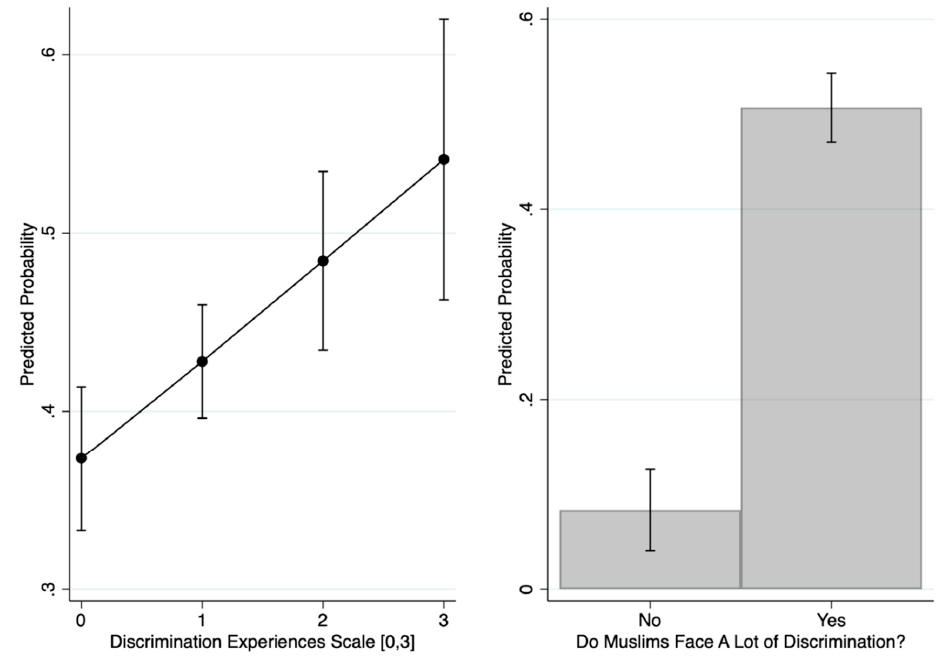
Figure 7. Predicted probability of perceiving discrimination against Jews, computed from models 5 (left) and 6 (right) of Table 4, which utilize 2017 data and include controls for age, gender, ethnicity, generation, income, mosque attendance, frequency of prayer, and political ideology.